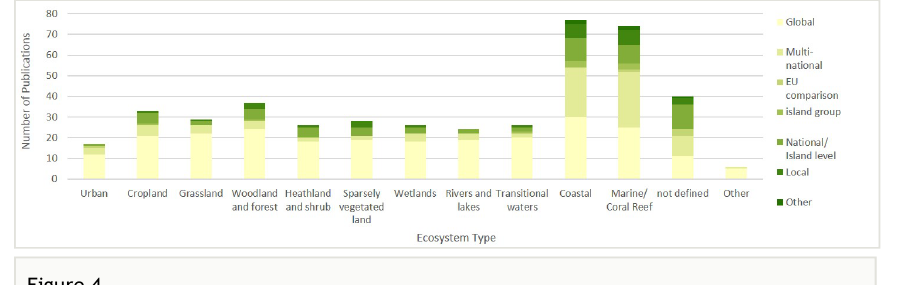
Overview of ecosystem types described in the 161 ES mapping and assessment publications and the spatial extent at which they performed (global, multi-national, within the EU context, island group, island level or local). Publications that did not de fi ne any spatial scale of analysis were classi fi ed as 'unde fi